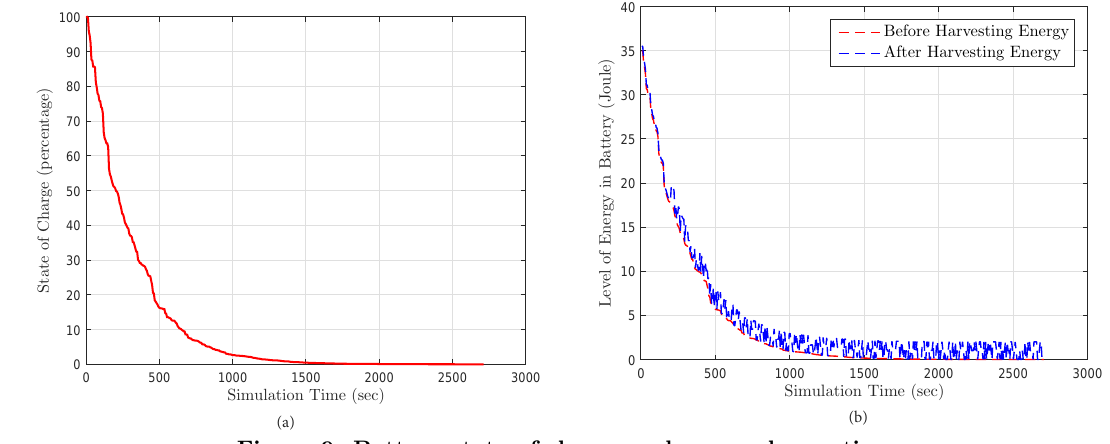
Figure 9: Battery state of charge and energy